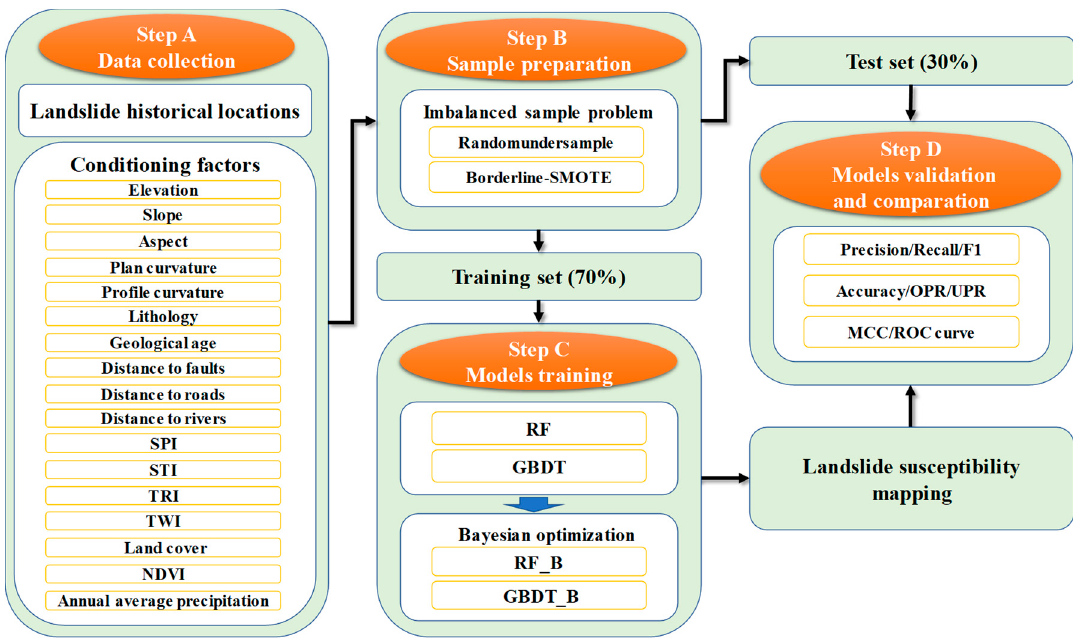
Figure 3. Flowchart of the proposed landslide susceptibility mapping (LSM) framework.